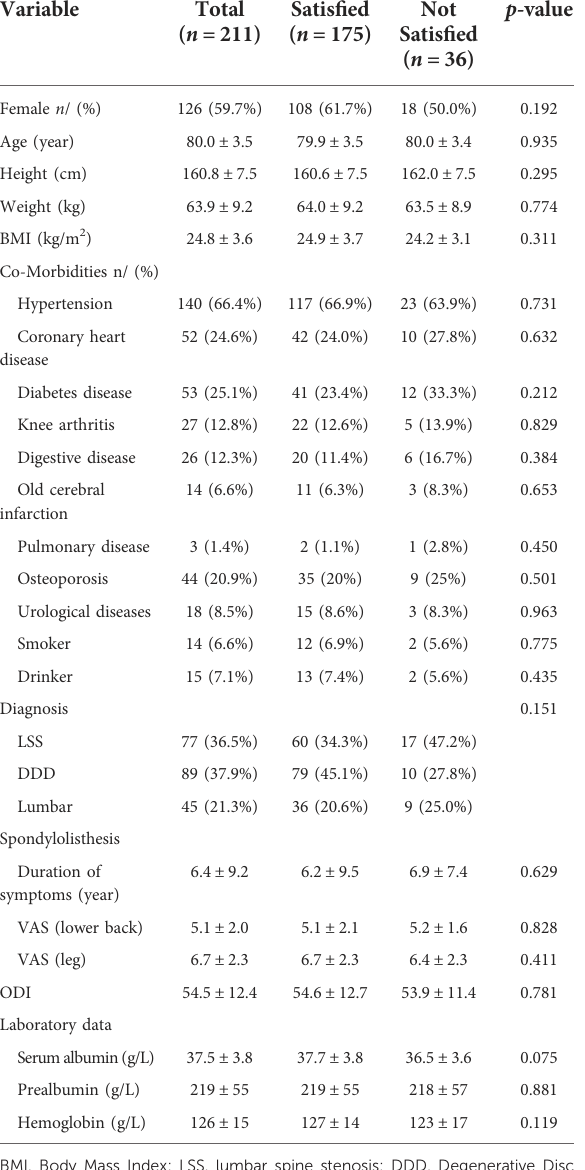
TABLE 2 Baseline characteristics and laboratory data of patients in the two groups.